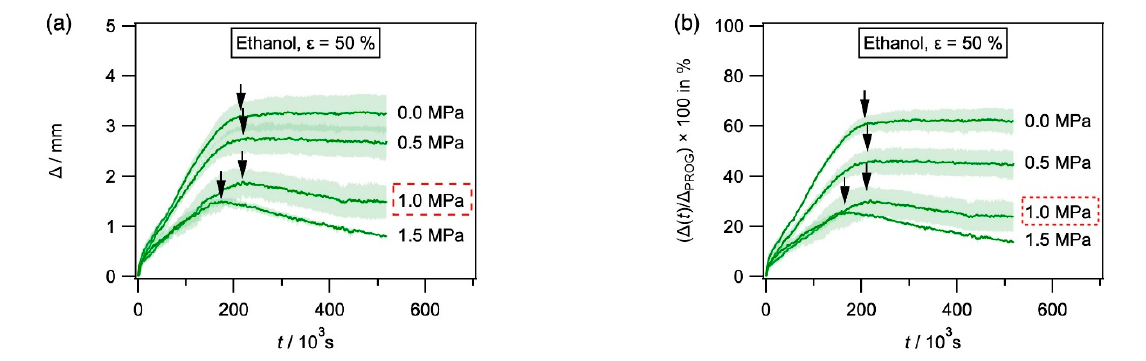
Figure 7. Evolution of ∆ with time for SMP-E specimens programmed to 50% and exposed to ethanol (unconstrained and with varying end loads). ( a ) ∆ in mm plotted as a function of time in s. ( b ) ( ∆ ( t )/ ∆ PROG ) × 100 in % vs. time in s.